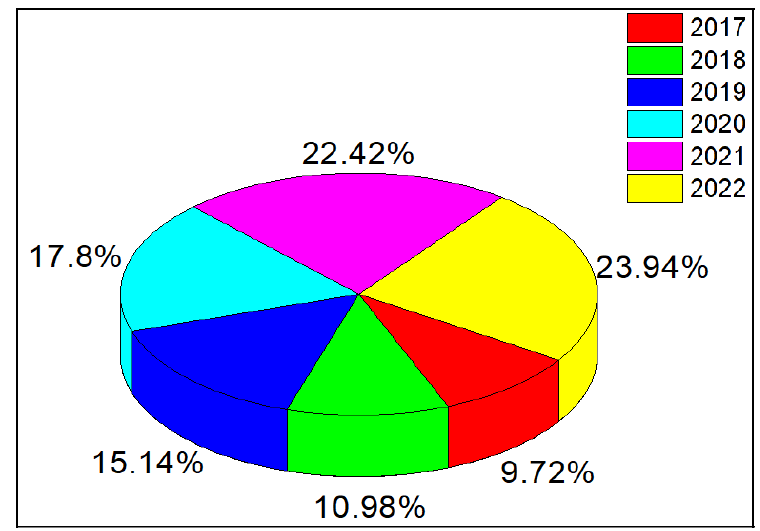
Figure 1. A pictographic chart shows an increasing percentage in the number of publications in the field of piezoelectric ZnO-based nanogenerators.